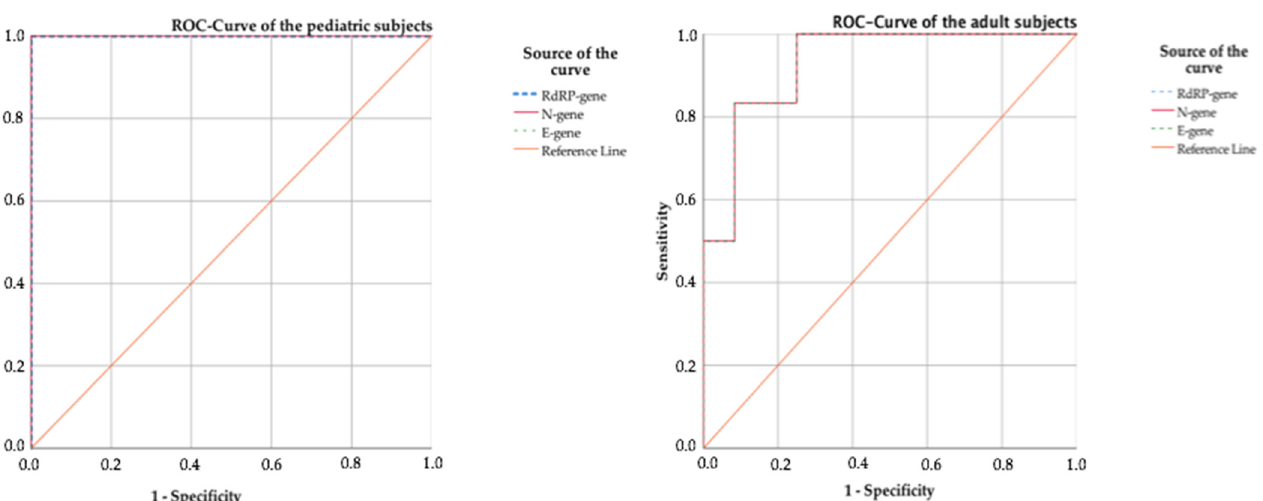
Figure A2. Distribution of different ct values from people tested either RAT+ or RAT − in the adult group.